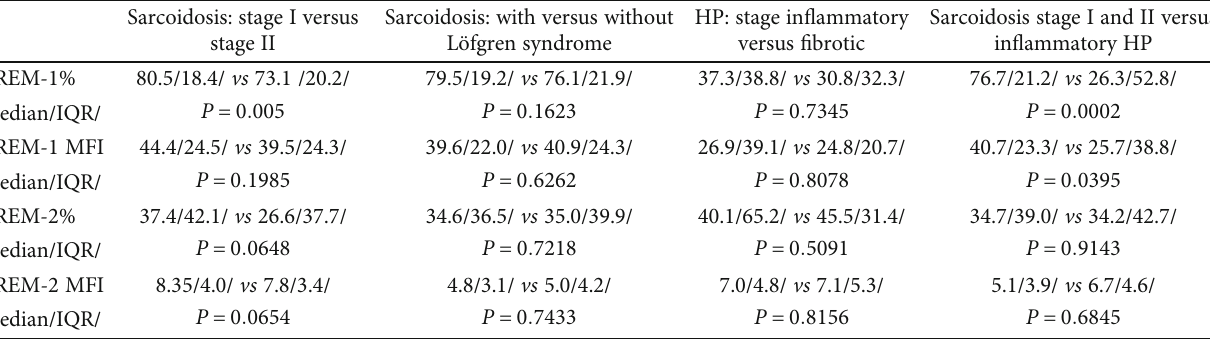
Table 3: Comparison of sarcoidosis and HP